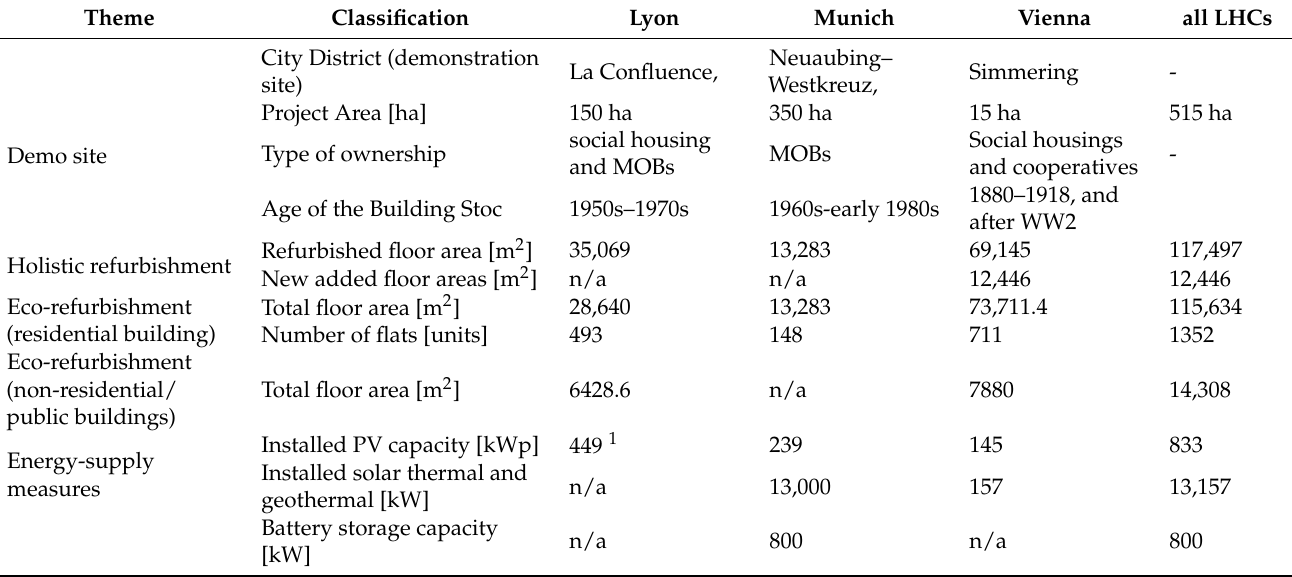
Figure 2. Lighthouse cities (LHCs) and follower cities (FCs) of the Smarter Together project as well as the LHCs of other EU projects that started in 2014. Table 1. Key specifications of the demonstration sites of the three